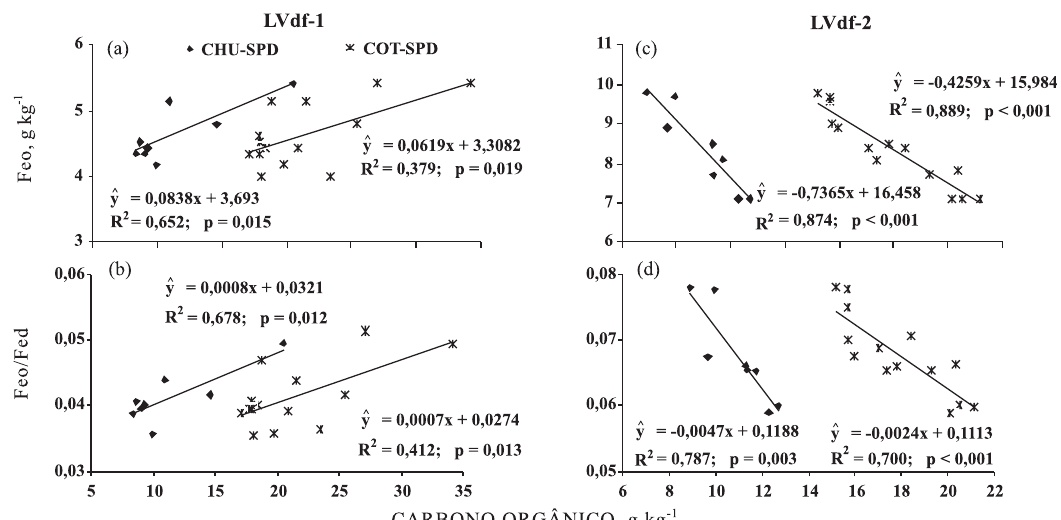
Figura 4. Relações dos teores de carbono orgânico total (COT) e da fração humina (CHU) com os teores de óxidos de ferro de baixa cristalinidade (Feo) e a razão Feo/Fed da fração argila ao longo da camada superficial dos solos LVdf-1 (a, b) e LVdf-2 (c, d), em sistema plantio direto (SPD). C